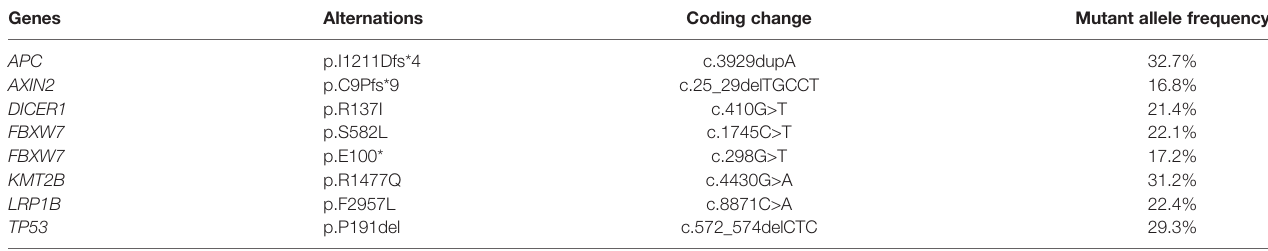
TABLE 1 | Genetic alternations in the rectal tumor tissues of the patient in case 2.